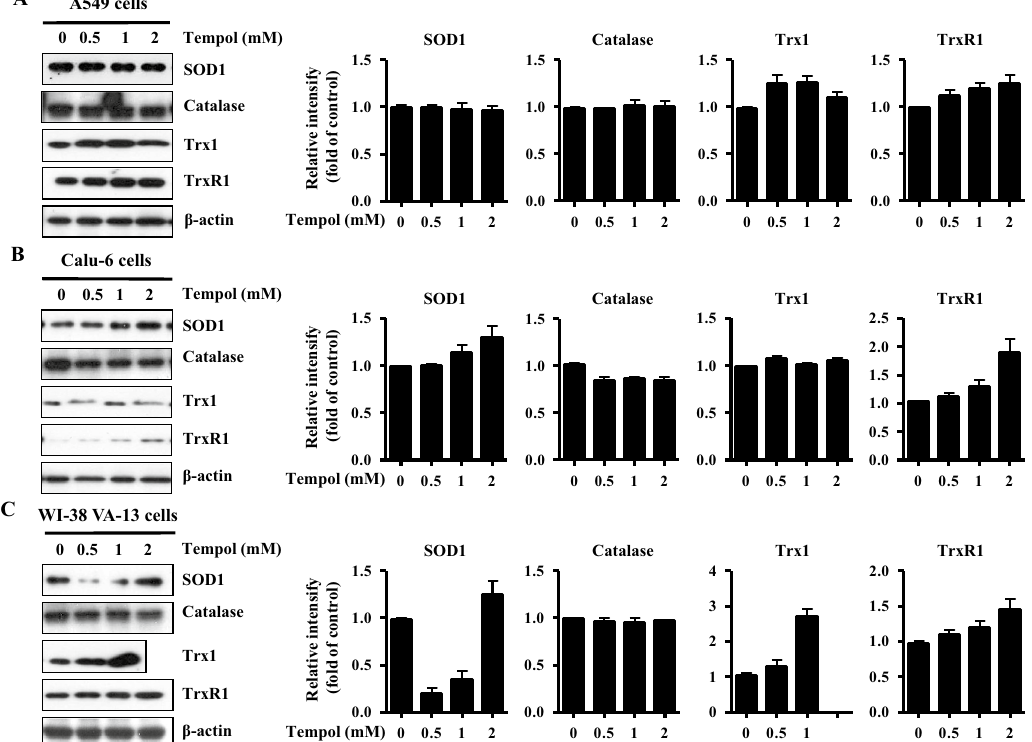
Figure 3. Effects of Tempol on the expression levels of SOD1, catalase, Trx1, and TrxR1 in lung cancer and normal cell cells. Exponentially growing cells were treated with indicated concentrations of Tempol for 48 h. Thirty μg of protein extracts from the tested lung cells were resolved by SDS-PAGE gel, transferred to PVDF membranes, and immunoblotted with the designated antibodies. Western blot analysis shows the levels of SOD1, catalase, Trx1, TrxR1, and β-actin in A549 cells ( A ), Calu-6 cells ( B ), and WI-38 VA-13 cells ( C ). The graphs represent the relative expression levels of SOD1, catalase, Trx1 and TrxR1 in A549 cells ( A ), Calu-6 cells ( B ), and WI-38 VA-13 cells ( C ). The expression of β-actin was used as an internal